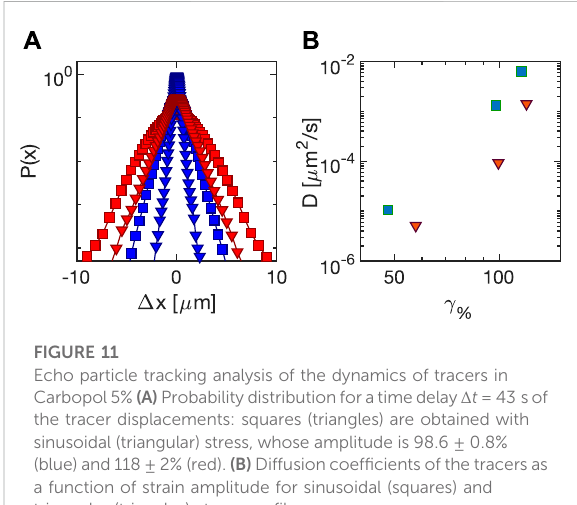
FIGURE 11 Echo particle tracking analysis of the dynamics of tracers in Carbopol5% (A) Probabilitydistributionforatimedelay Δ t =43 sof the tracer displacements: squares (triangles) are obtained with sinusoidal (triangular) stress, whose amplitude is 98.6 ± 0.8% (blue)and 118±2% (red). (B) Diffusioncoef fi cients ofthetracersas a function of strain amplitude for sinusoidal (squares) and triangular (triangles) stress pro fi